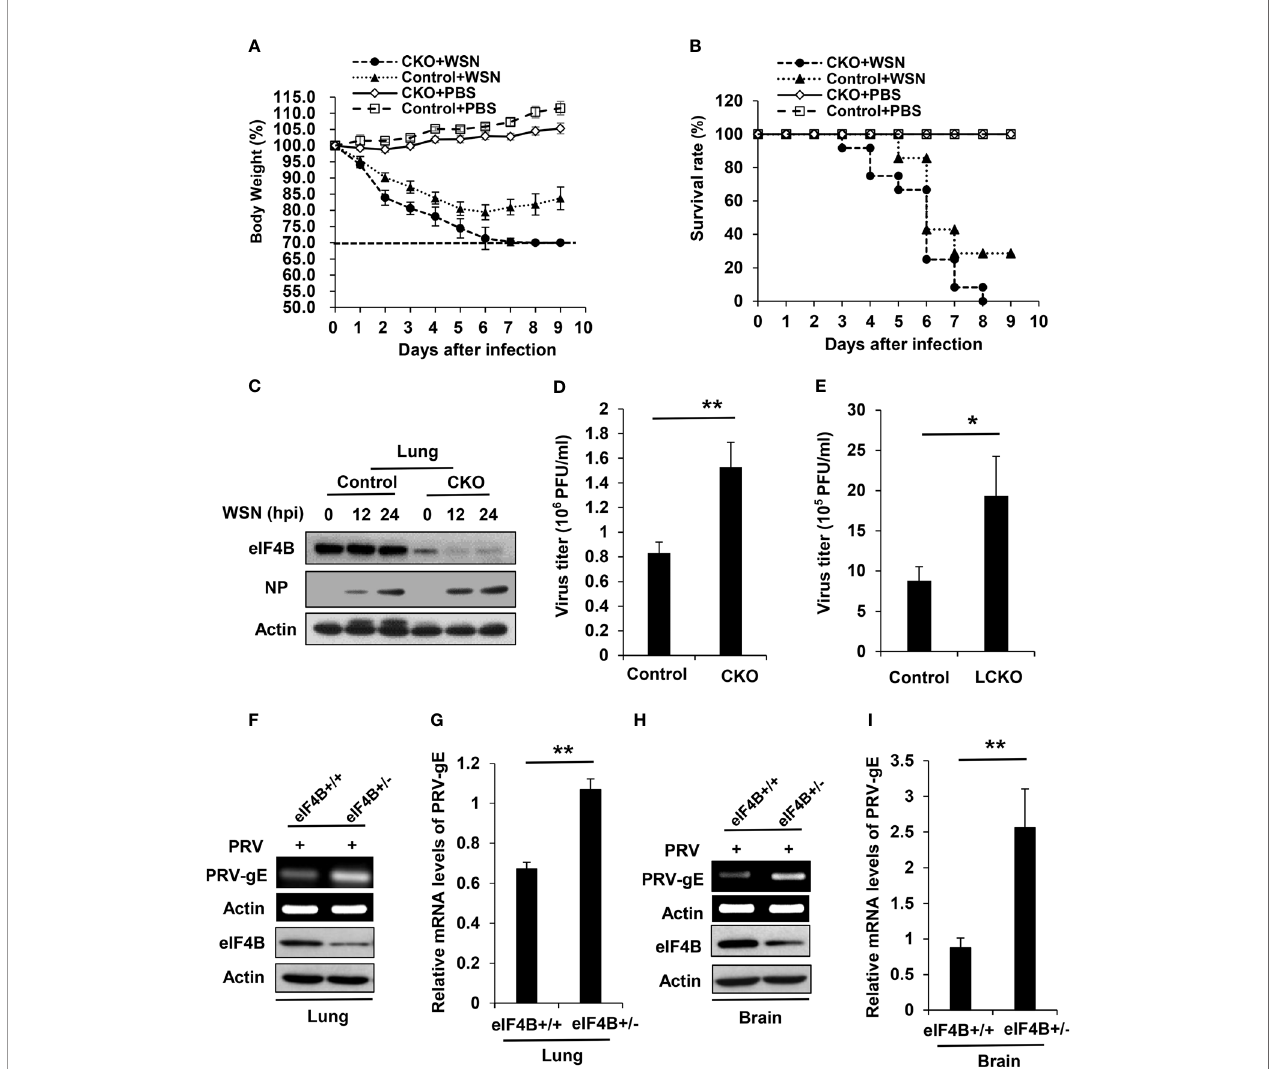
FIGURE 4 | eIF4B-de fi cient mice are highly susceptible to viral infection. (A, B) Shown are body weight change (A) and survival rate (B) of eIF4B CKO and control mice intranasally infected with/without WSN. (C) Western blot analysis of eIF4B and IAV NP (Nucleoprotein) levels in lung lysates from eIF4B CKO and control mice infected with/without WSN virus. (D) Lung viral loads in infected eIF4B CKO and control mice were measured by plaque forming assay. (E) Viral loads in the lungs of eIF4B f/f SPC-rtTA/Teto-Cre (eIF4B LCKO) and eIF4B f/f (control) mice infected with WSN. (F, G) eIF4B +/+ and eIF4B +/- mice were infected with PRV. The expression levels of PRV-gE in the lungs were analyzed by RT-PCR (F) and qRT-PCR (G) . (H, I) The expression levels of PRV-gE in the brains from eIF4B +/+ and eIF4B +/- mice infected with PRV were analyzed by RT-PCR (H) and qRT-PCR (I) . Data are represented as mean ± SD. **p ≤ 0.01 and *p ≤